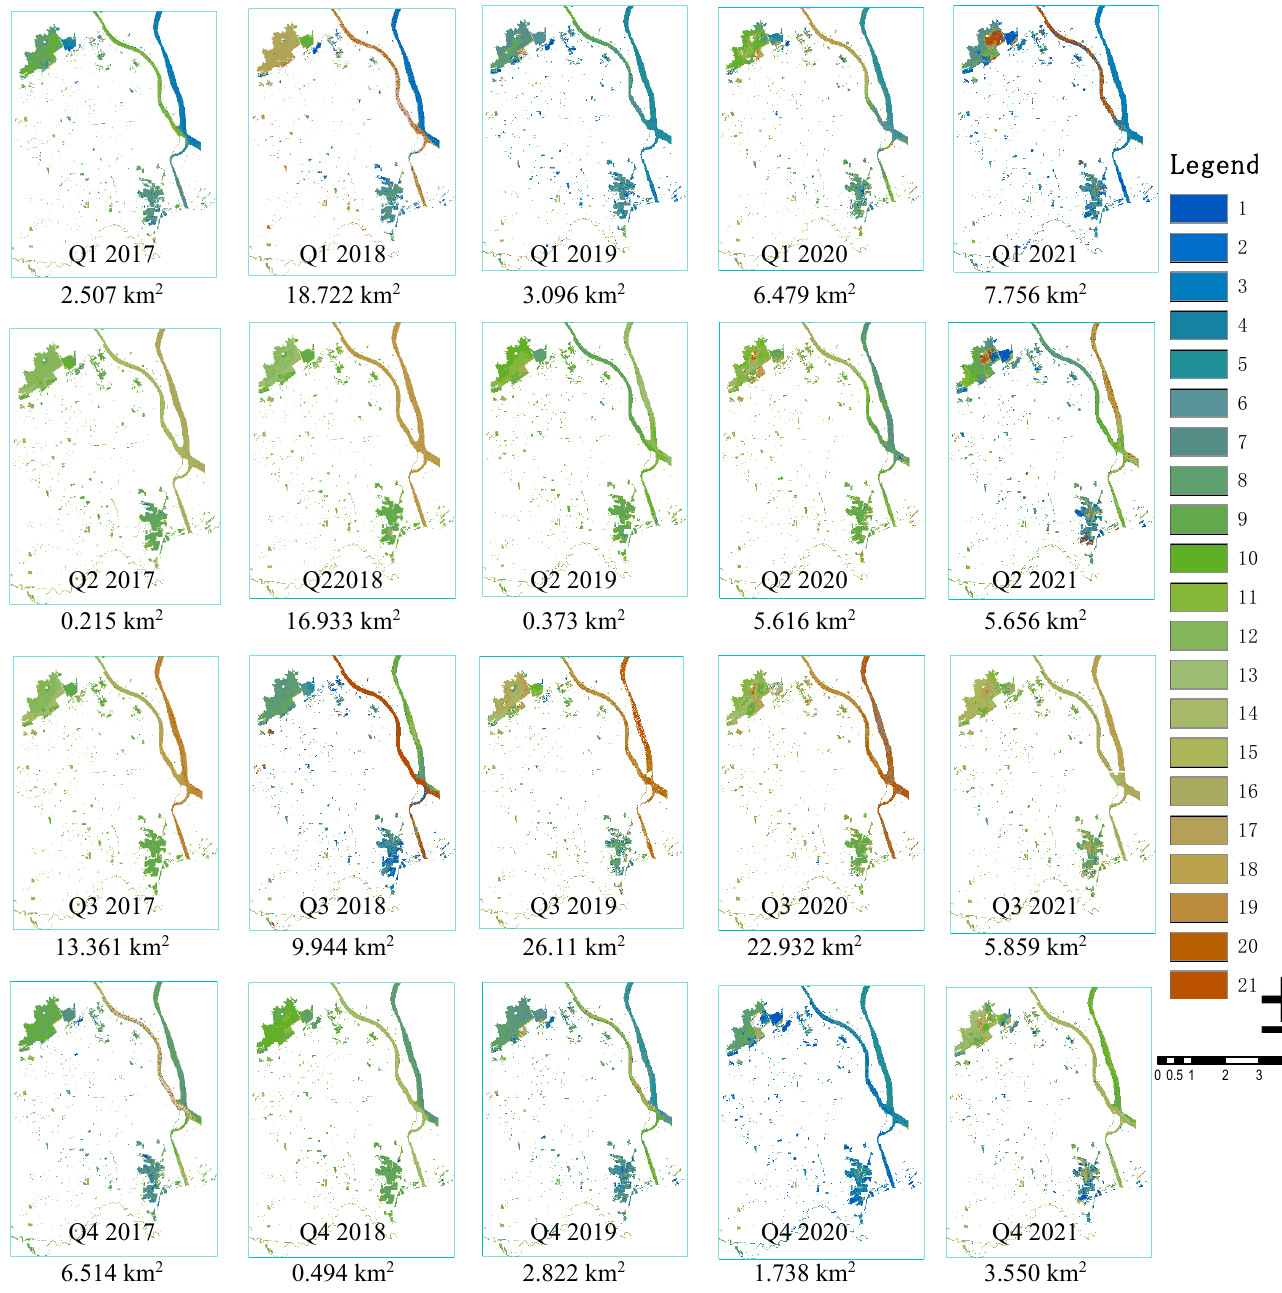
Figure 7. Quarterly FUI distribution map. In this study, the frequency of occurrence map of surface water body eutrophication is obtained by overlaying the 20 pairs of FUI distribution maps in Figure 9 and reclassifying the data into five levels. Based on the eutrophication occurrence frequency map, the higher frequency (level 5) points of grid centers are taken as the demand point to respond to the water ecosystem